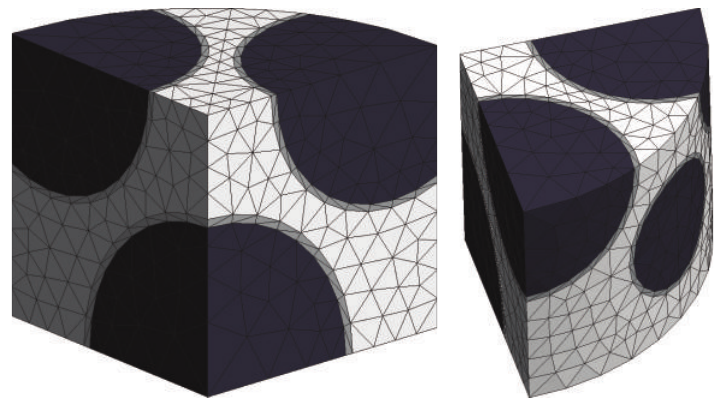
Figure 1: Base cell at the